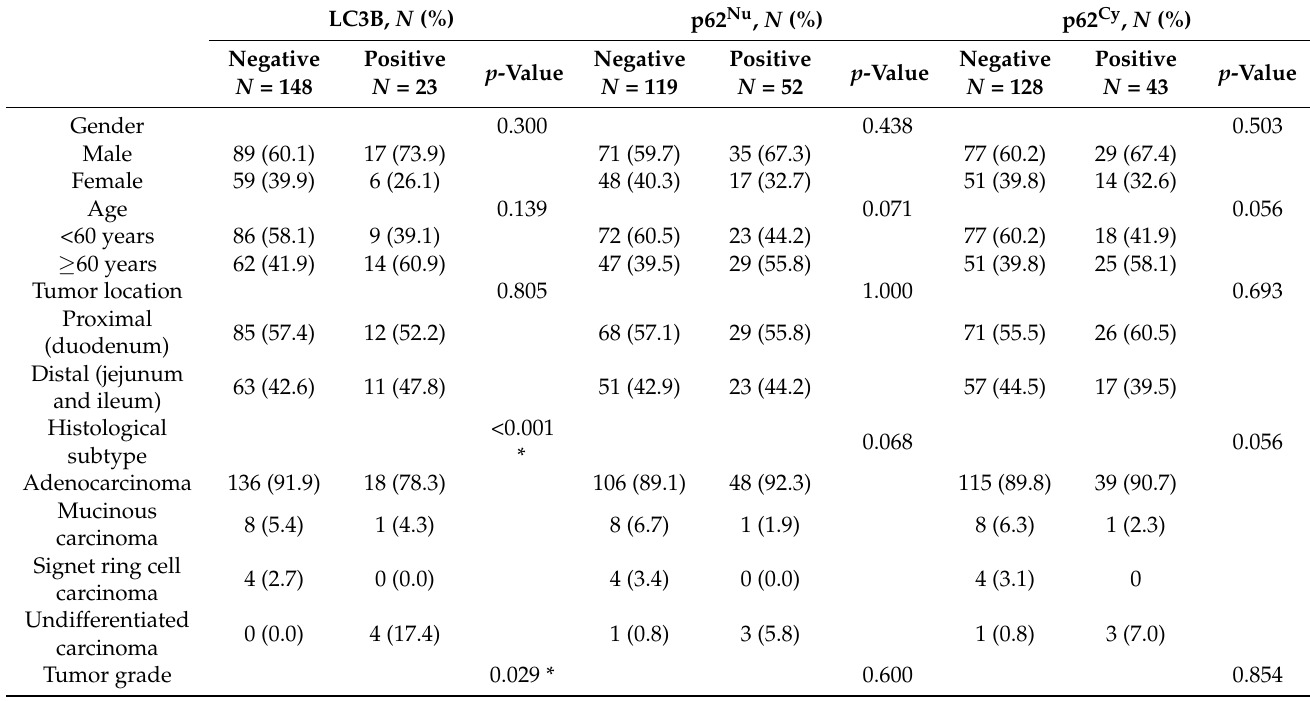
Table 3. The association between clinicopathologic features and p62 and LC3B expression in patients with